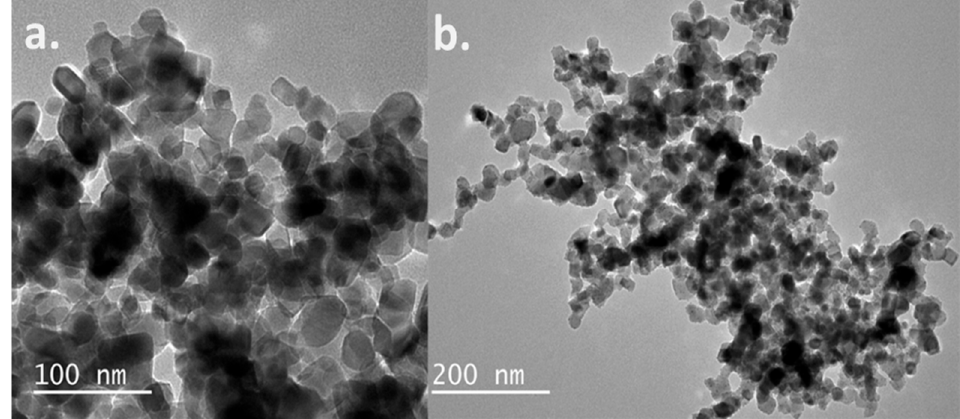
Figure 4. Transmission electron microscopy of Silver Nanoparticles (AgNPs) ( a ) and AgNPs with titanium dioxide nanoparticles ( b ).